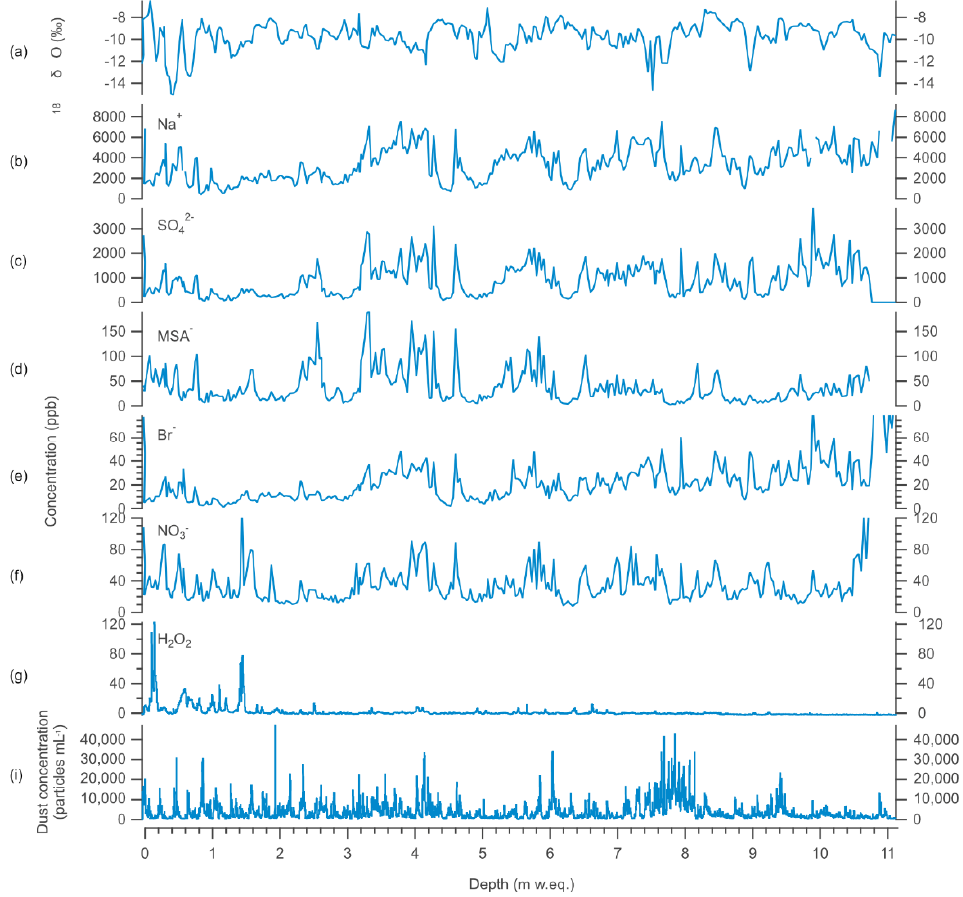
Figure 5. Full glacio-chemical records acquired from the Young Island ice core; ( a ) stable water isotope ratio δ 18 O; concen- trations of ( b ) sodium, ( c ) sulfate, ( d ) methanesulfonate, ( e ) bromide, ( f ) nitrate, ( g ) hydrogen peroxide, and ( i ) dust, de- fined as insoluble particulate